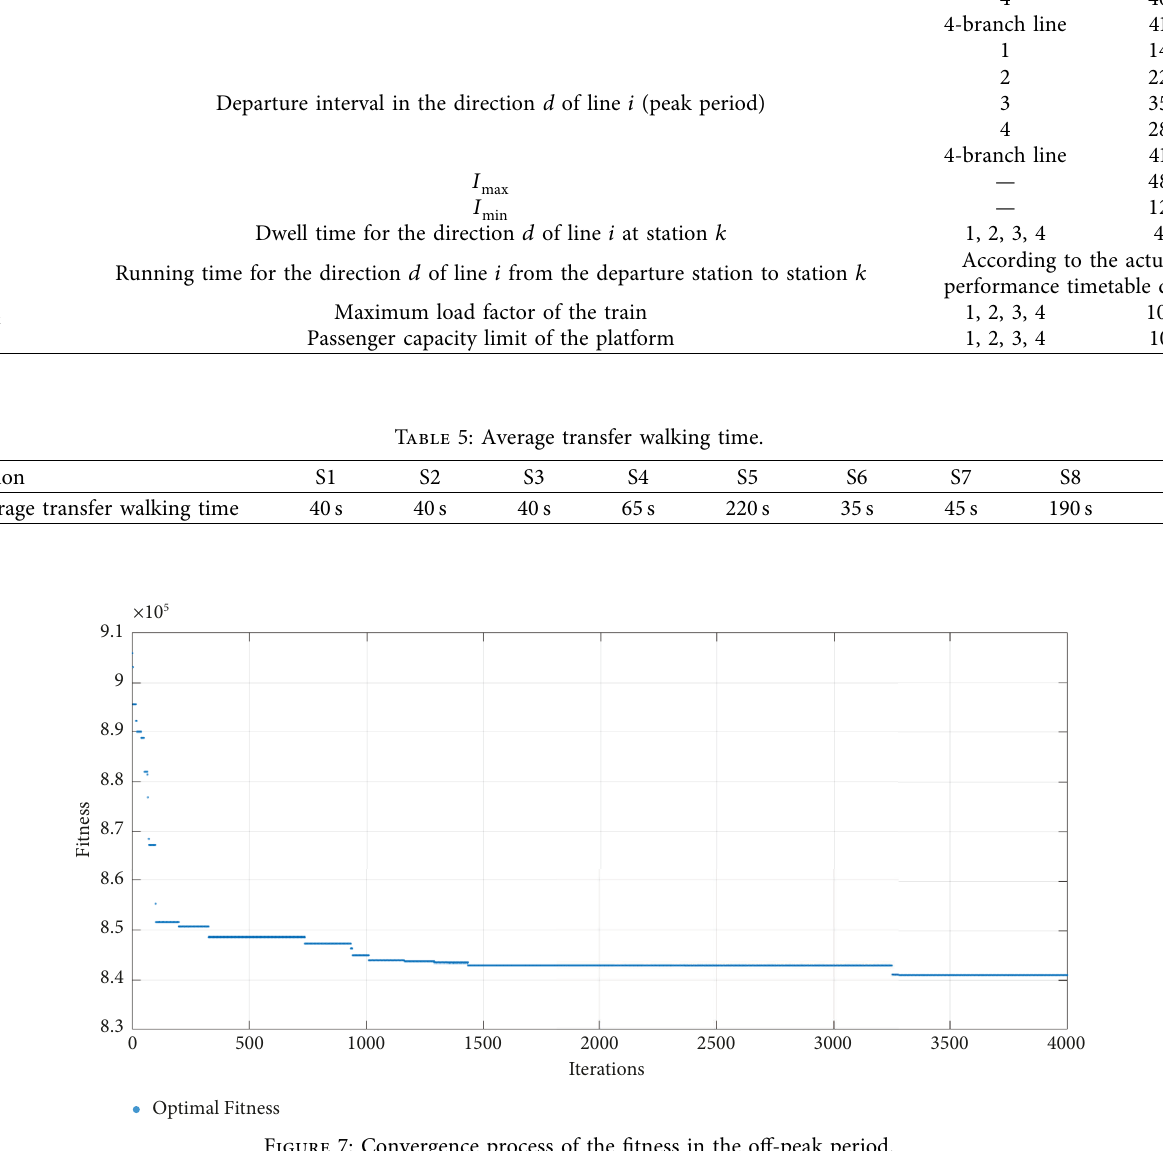
Figure 7: Convergence process of the fitness in the off-peak